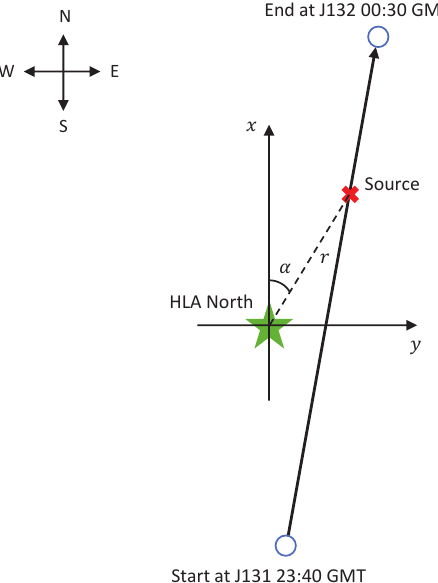
Figure 13. Map of the source movement and the location of the hydrophone array.